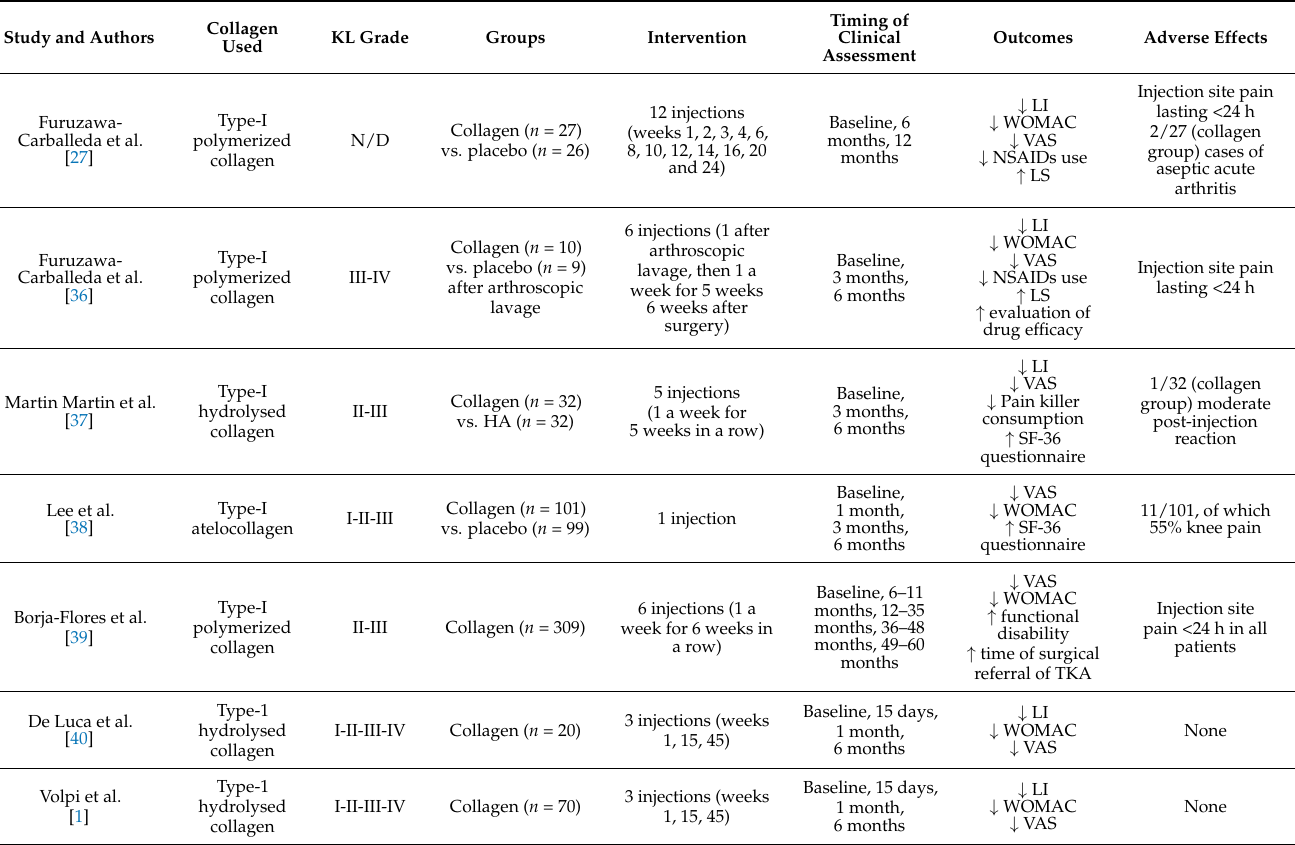
Table 1. A summary of the outcomes of the selected